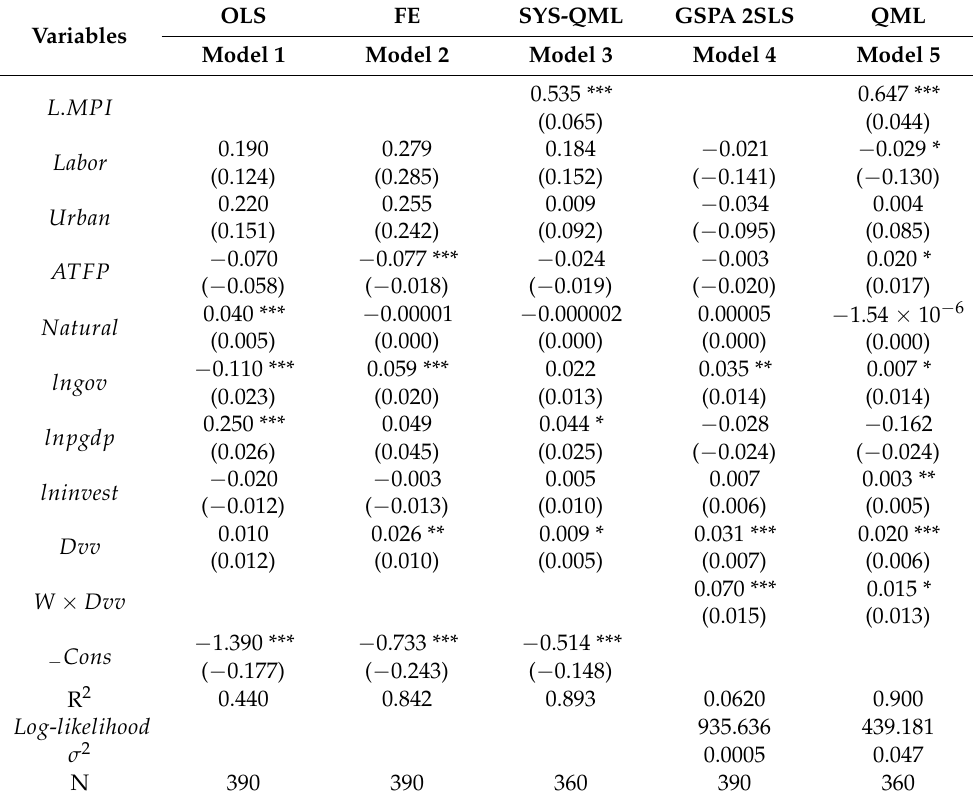
Table 3. The direct effect estimation results of dynamic spatial Durbin